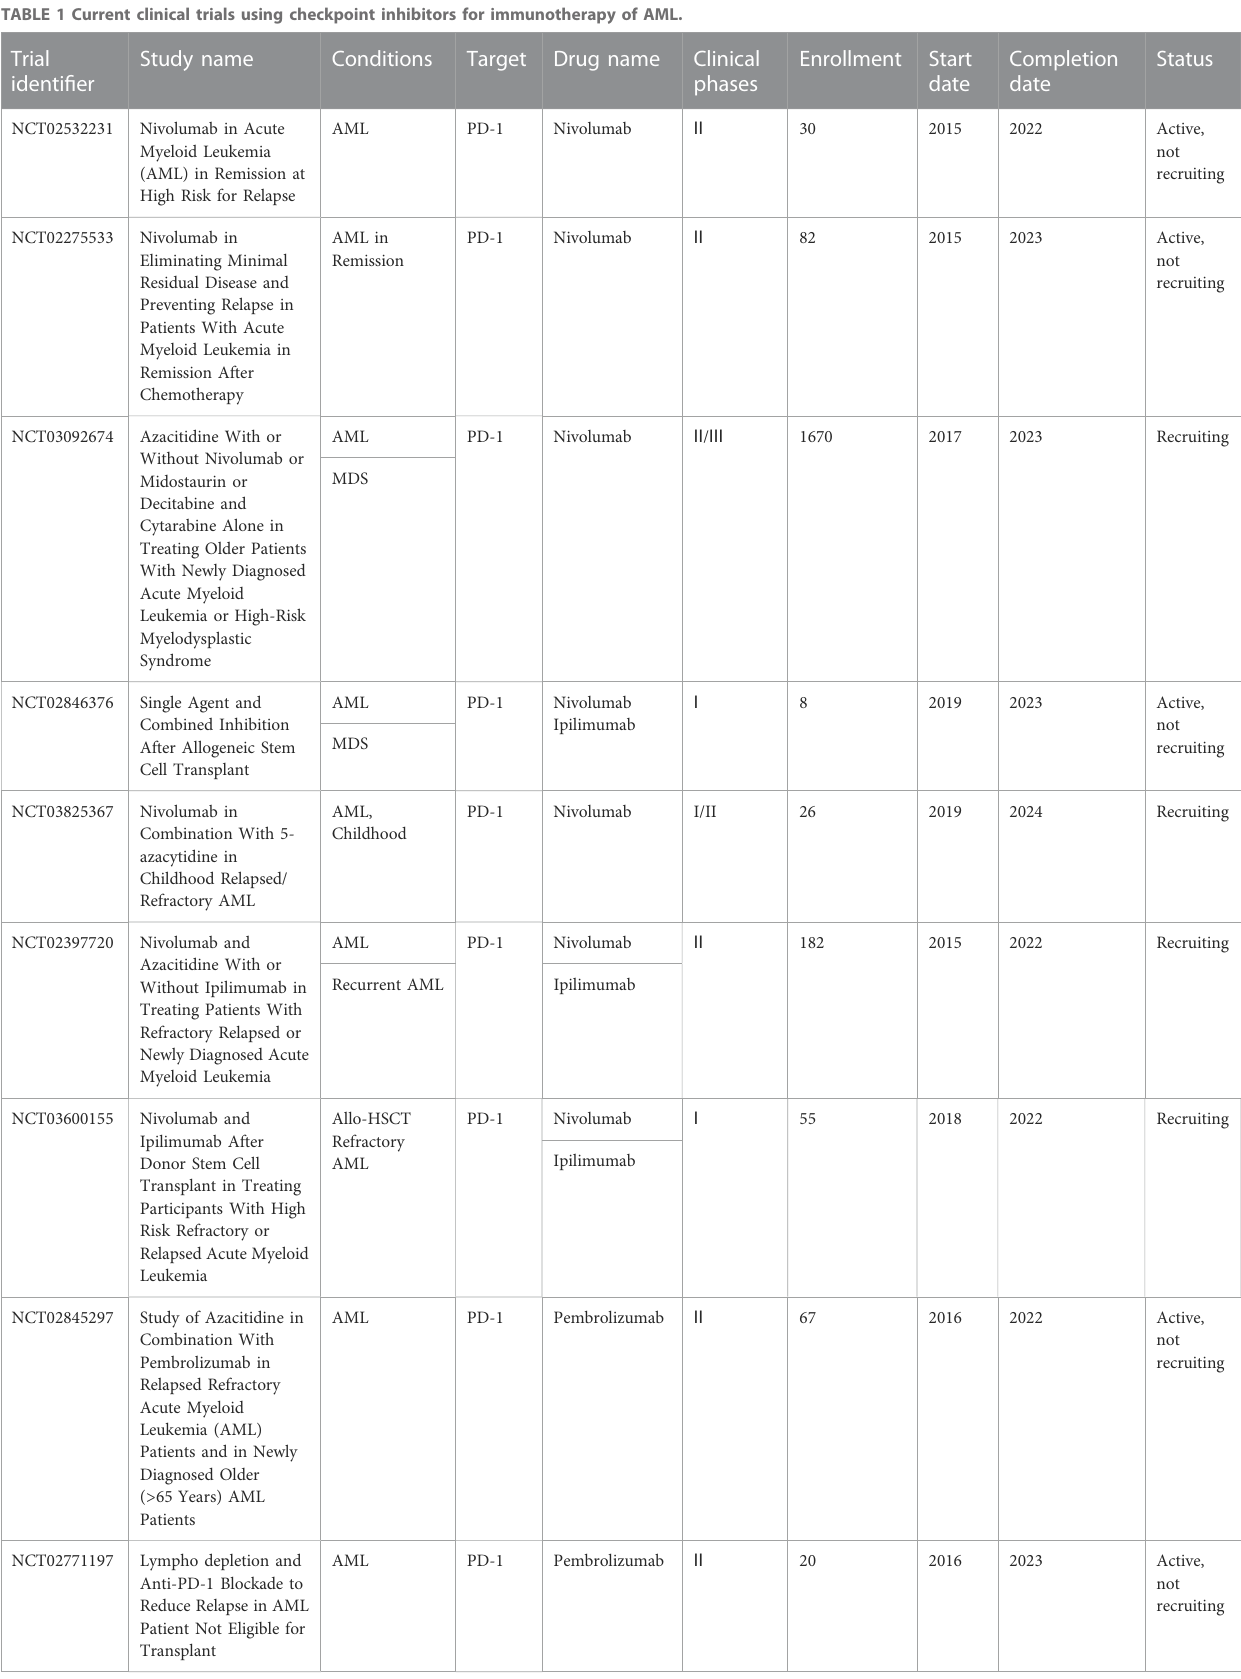
TABLE 1 Current clinical trials using checkpoint inhibitors for immunotherapy of